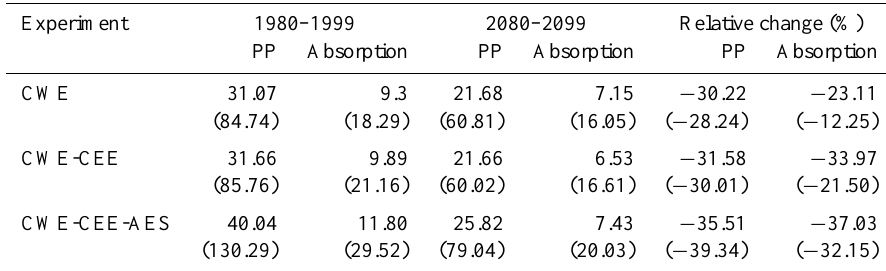
Fig. 6. (a) Annual mean of surface temperature (red) and salinity (blue) averaged over the North Sea. Dotted lines indicate the control integration CTRL, (b) annual mean bottom-surface salinity difference averaged over the North Sea, (c) 0–100m (black) and 614–713m (red) water temperature averaged over the continental slope northwest of the North Sea (12 ◦ W–6 ◦ W; 56 ◦ N–61 ◦ N, indicated by the red box in Fig. 7), (d) same as (c) but for salinity, (e) yearly primary production integrated over the North Sea. Dotted lines indicate the control integration CTRL, (f) carbon absorption of the North Sea (MtC). Dotted lines indicate the control integration CTRL, (g) winter gross mass transports of nitrate into the North Sea calculated from experiment CWE, (h) same as (g) but for phosphate. Note: hydrographic properties in (a–d) are the same in all scenario experiments. Table 2. Budgets of absorption (defined as net C flux into the water column in million tons of carbon) and biological production (million tons of carbon) for the North Sea calculated over the last two decades of the 20th and 21st centuries. Numbers in brackets indicate budgets calculated for the entire NW European shelf (all areas between 37 ◦ N and 65 ◦ N adjacent to the North Atlantic and shallower than 200m). Last two columns indicate the relative change from 1980–1999 to 2080–2099. PP is primary